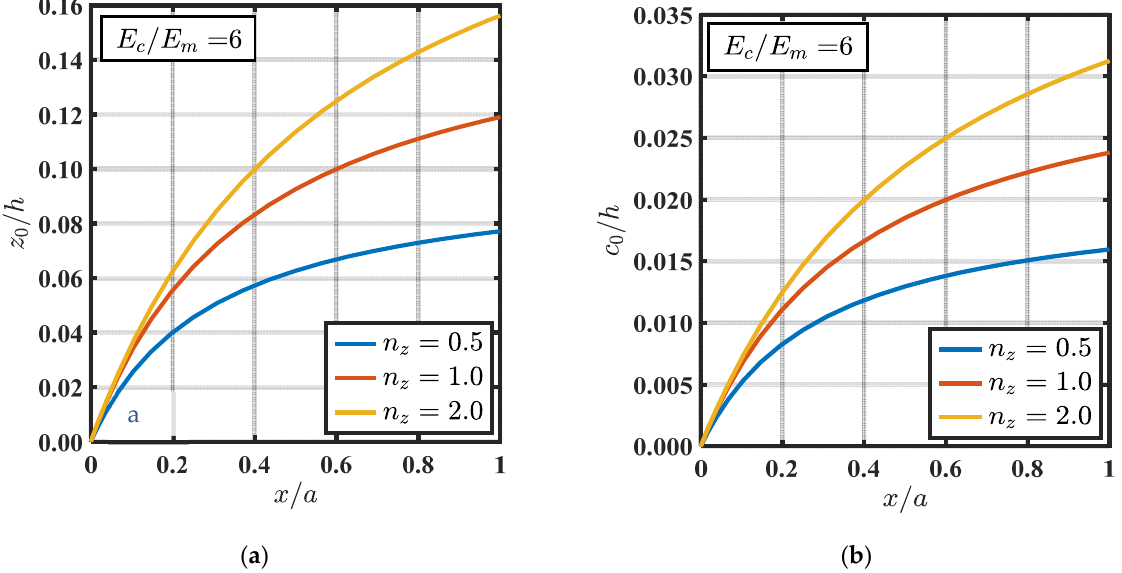
Figure 4. Neutral axis paramaters z 0 / h and c 0 / h at different n z and young’s modulus of ceramic and metal, E c / E m = 6 at ( a / h = 10, n x = 1 ) ( a ) for z 0 / h and ( b ) for c 0 / h .